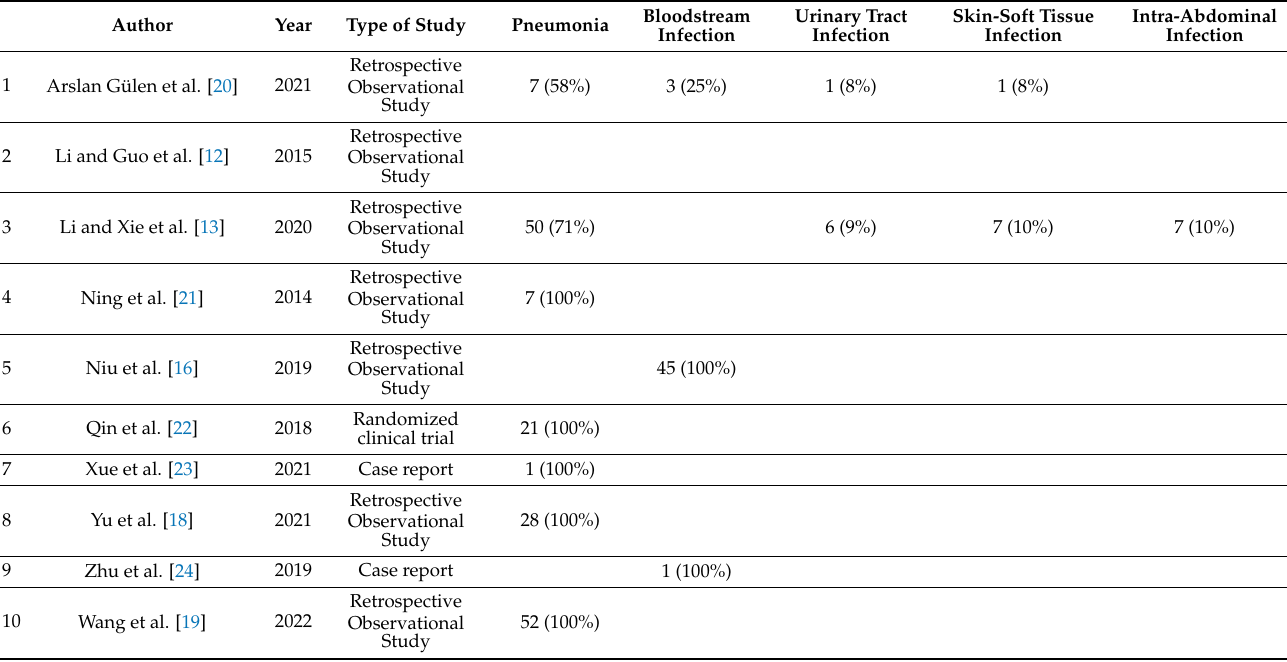
Table 2. Types of infection in which cefoperazone-sulbactam was used in combination.